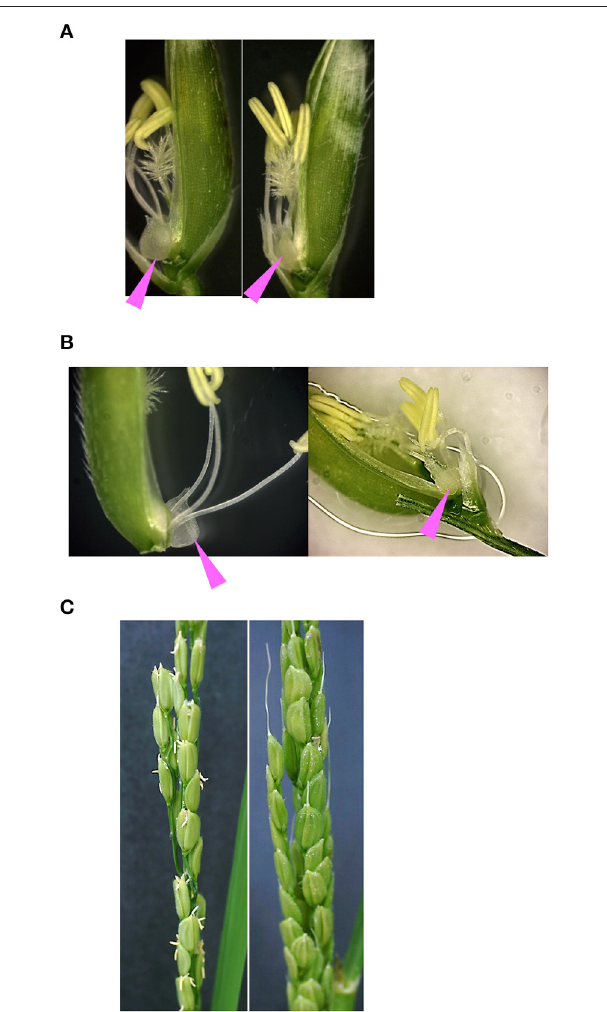
FIGURE 6 | Phenotype of floral organs in GT homozygous plants. Photos of segregated WT (left) and GT homozygous (right) plants in the T 1 generation harboring an A to G substitution at the 8th position (variation 1) at the miR172 target site in the OsCly1 gene possessing a positive selection marker. Pink arrowheads indicate lodicules. (A,B) Spikelets (WT and GT plants) of #34-6-53 observed under a light microscope. (C) Panicles (WT and GT plants) of #441-113-115-38 at flowering